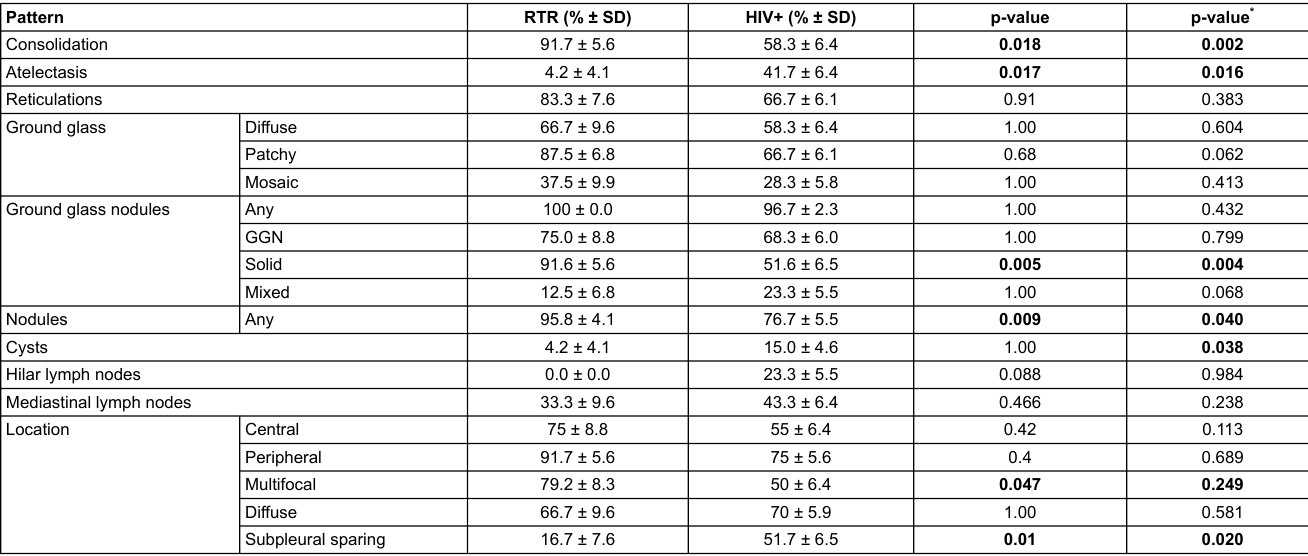
Table 2: Pneumocystis jirovecii pneumonia lung patterns and locations on computed tomography.